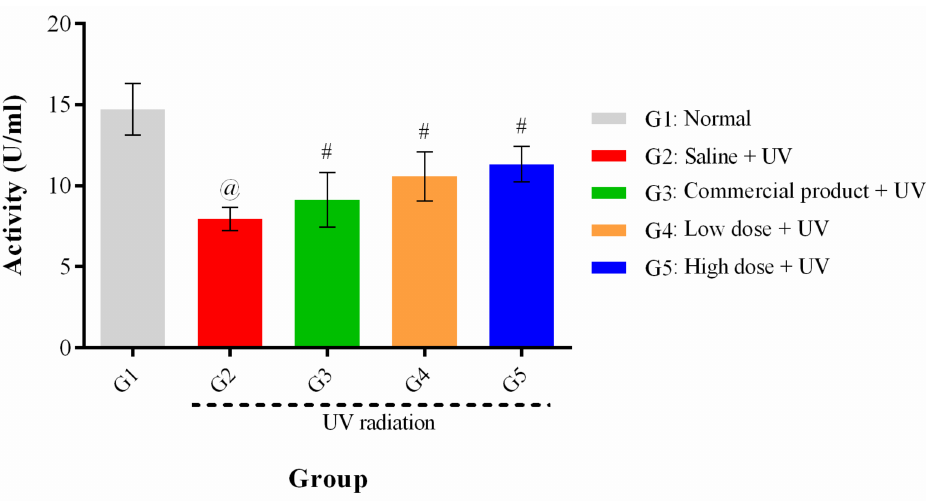
Figure 10. Effect of treatment on the SOD activity. All treated groups showed higher SOD activity compared to the G2 group with no significant difference among them. Data represented as the mean ± SD. @: significant difference in comparison to normal group #: significant difference in comparison to control group p < 0.05/ n =